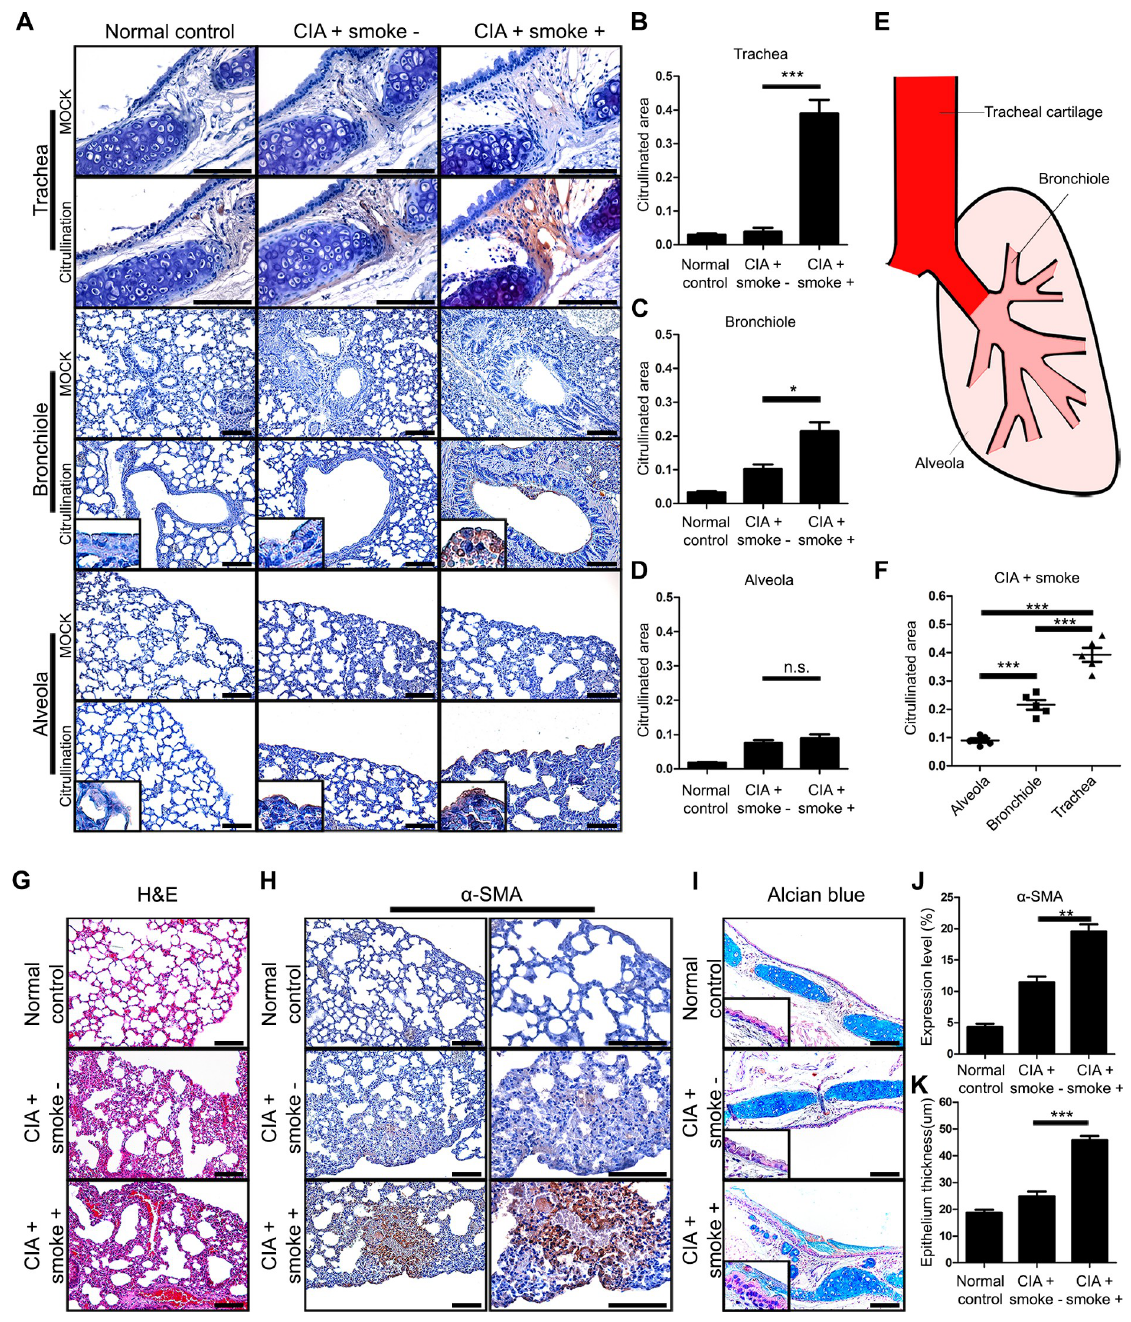
Fig 3. Cigarette smoke alters the respiratory tract in CIA mice. (A) Immunohistochemical staining was performed for tracheal, bronchiolar, and alveolar tissue. (B-D) The expression level of each tissue was quantified. (E) Schematic showing the hypothesized distribution of cigarette smoke reaching different parts of the lung. (F) Comparison of the expression level of each tissue. (G-I), Lung morphology shown by H&E staining and α -SMA protein expression by IHC. (J, K) Expression level of α -SMA and epithelium thickness was quantified. Data are the mean ± SEM, � p < 0.05; �� p < 0.01; ��� p < 0.001 by one-way ANOVA. CIA, collagen-induced arthritis; n.s., non- significant. Scale bars, 100 μ